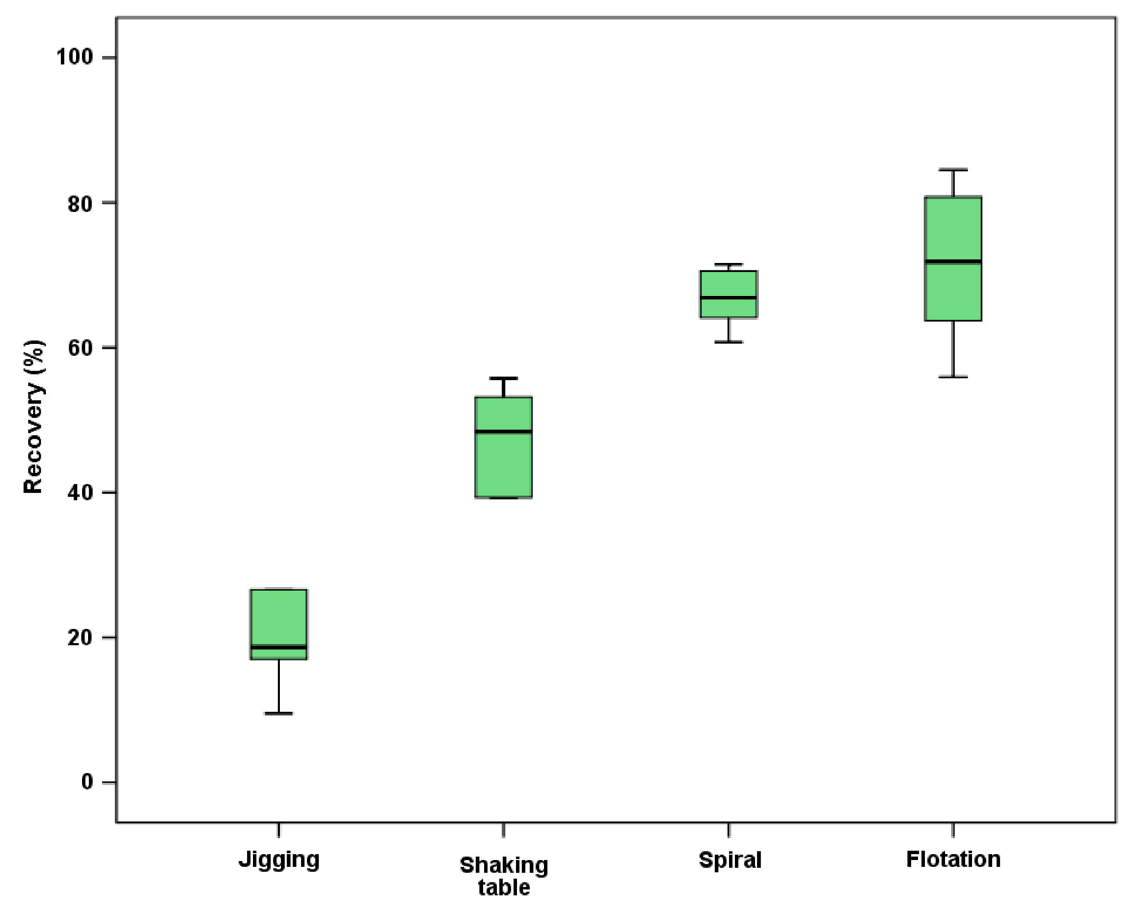
Fig. 3 A comparison among provided coal recoveries of various separation